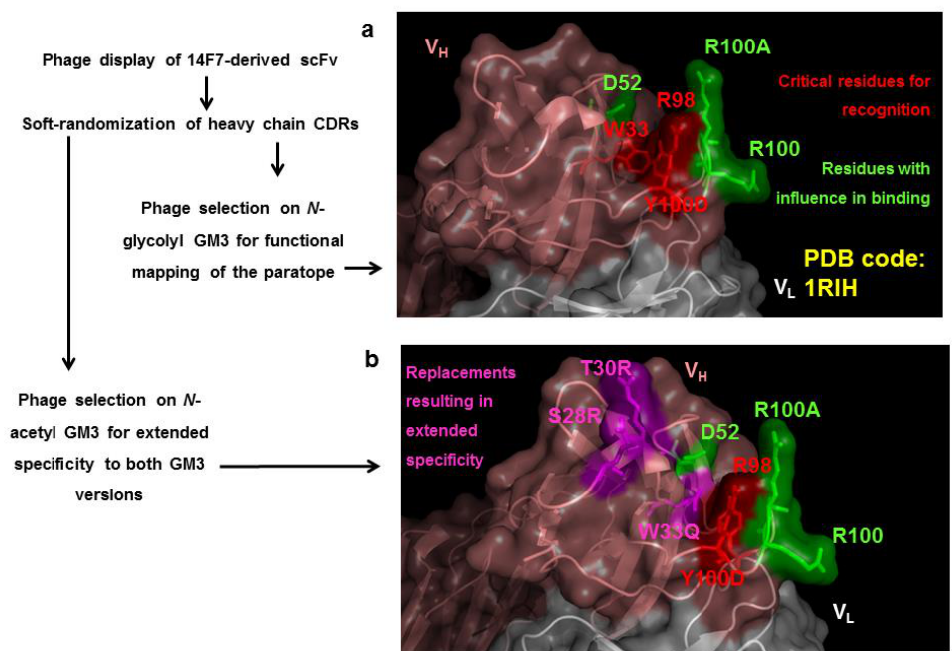
Figure 5. Directed evolution of cross-reactive paratopes from an anti-ganglioside antibody. ( a ) Functional map of 14F7 antibody paratope, defined through selection of phage-displayed antibody fragments from a heavy chain CDRs soft-randomization library on immobilized N -glycolyl GM3 ganglioside antigen [85]. Residues W33, R98 and Y100D were strictly conserved among antigen-reactive variants (critical determinants of antibody recognition, highlighted in red), while D52, R100 and R100A (indicated in green) also played a role in binding. ( b ) Selection on a second antigen (the structurally related N -acetyl GM3) rendered cross-reactive binders with broader specificity for both gangliosides. The newly evolved paratopes kept the same functionally relevant residues, except for three changes that determined specificity extension. Modifications arising during directed evolution included the replacements W33Q, S28R and T30R (magenta). The overlapping between the original paratope and the cross-reactive variant indicates that they share a similar binding mode with subtle differences, even in the absence of structural information about the complexes.